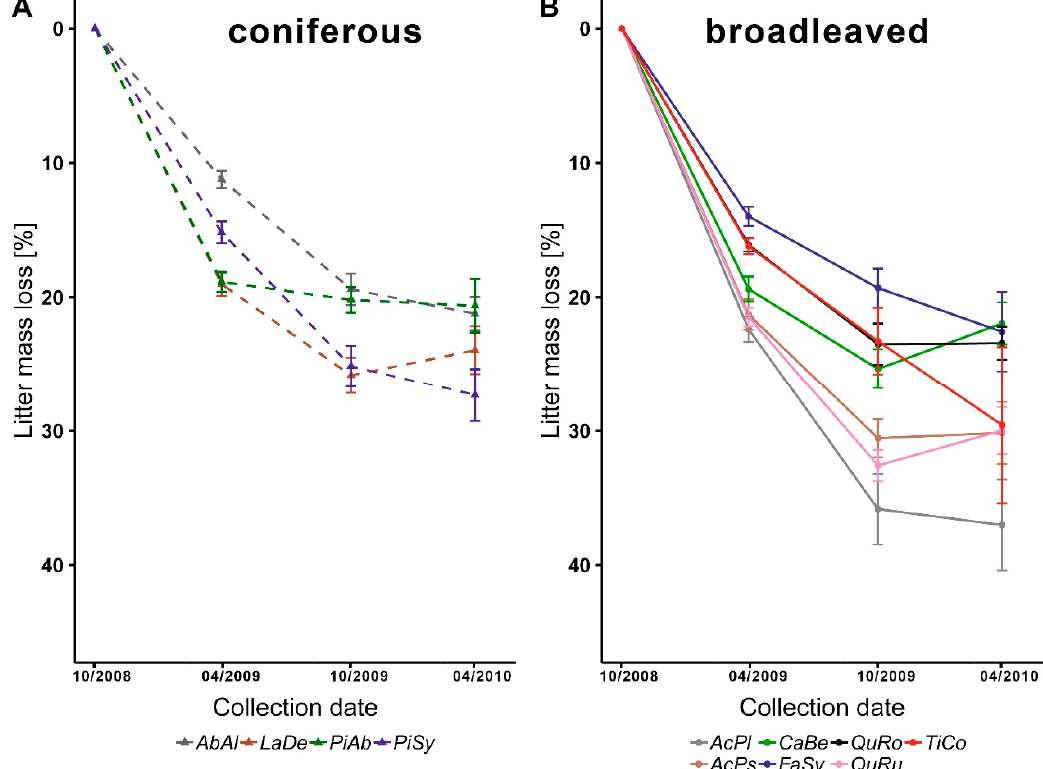
Figure 5. Litter mass loss [%] of coniferous ( A ) and broadleaved ( B ) species in litterbags. Data are presented as mean ±